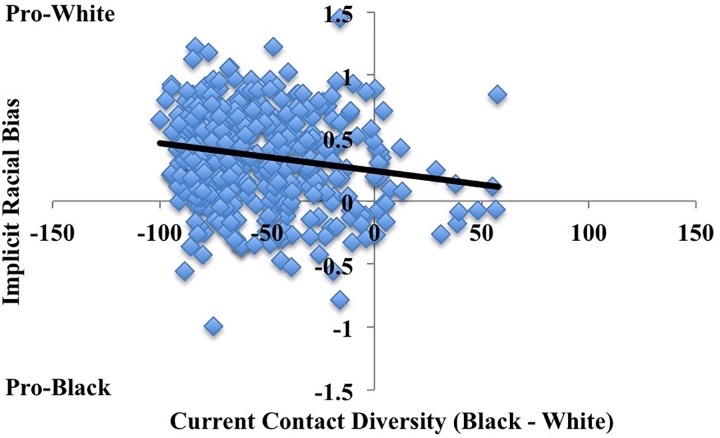
Relationship between current contact and implicit racial bias in Study 1.Higher values on implicit racial bias refer to more pro-White associations and lower numbers refer to more pro-Black associations. Overall, greater diversity in contact (Black contact–White contact) related to lower implicit racial bias (IAT D-scores).